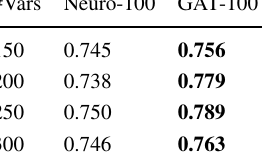
Table 3 Experimental results on the trained on 100 variables and tested on the other scales